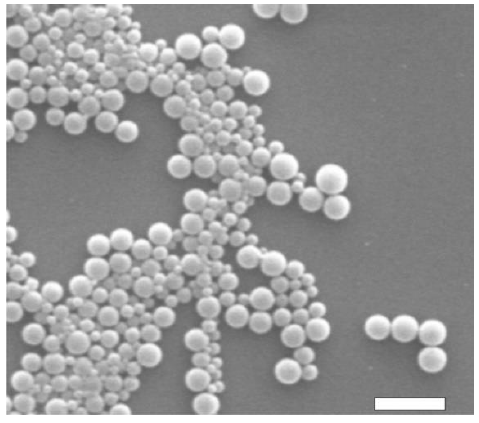
Figure 2. SEM micrograph of PDLLA NPs. Scale bar: 1 μm.